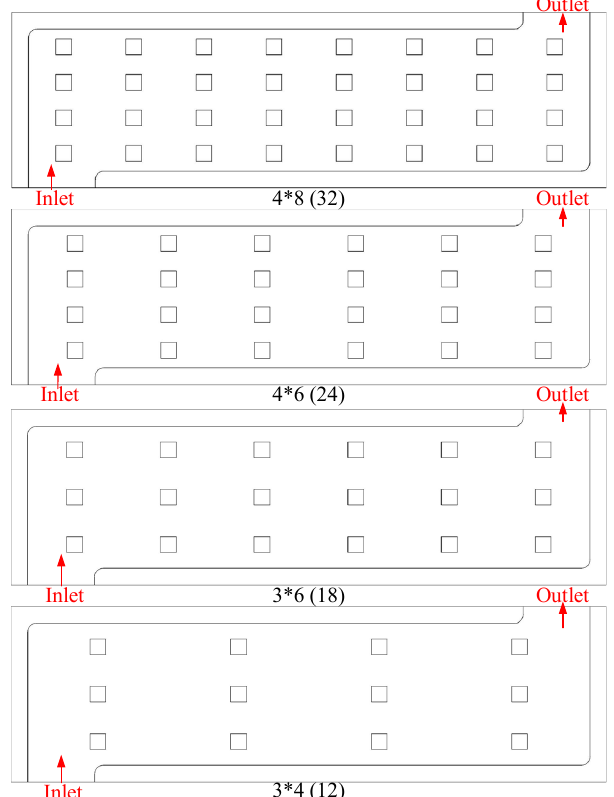
Figure 10. The cooling plate has a different number of pin-fins.